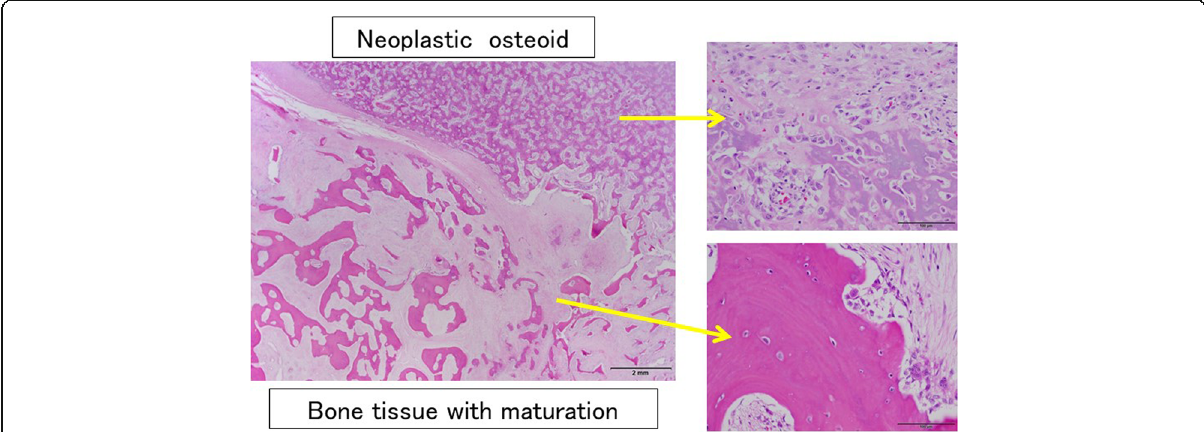
Fig. 5 The histopathological examination. The proliferation of atypical cells with oval to round nuclei and eosinophilic cytoplasm with abundant osteoid and bone formation are seen at the periphery of the tumor. The center of the tumor is composed of hypocellular fibrous maturation. Mitotic figures are frequently seen, but abnormal mitotic figures are not evident